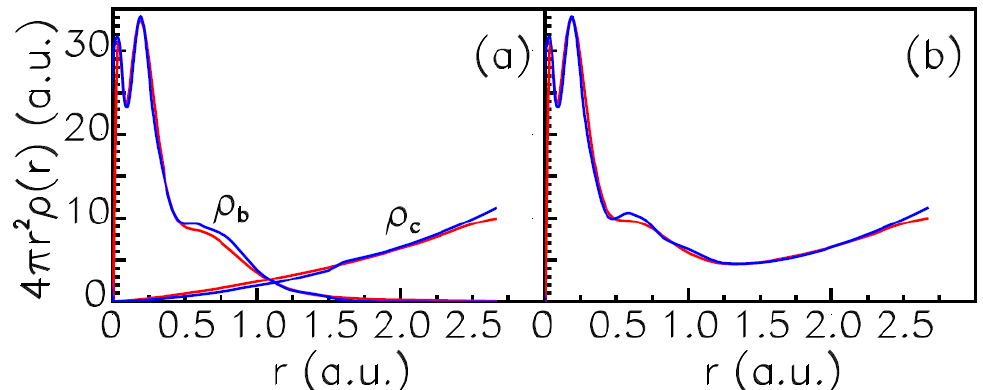
Figure 10. The bound and continuum electron densities ( a ) and the total density ( b ) calculated using the DS-Thomas–Fermi (TF) model for the iron ion in laser plasmas at T = 100 eV and the normal density 7.87 g/cm 3 , R temperature k β present calculations; blue, calculations